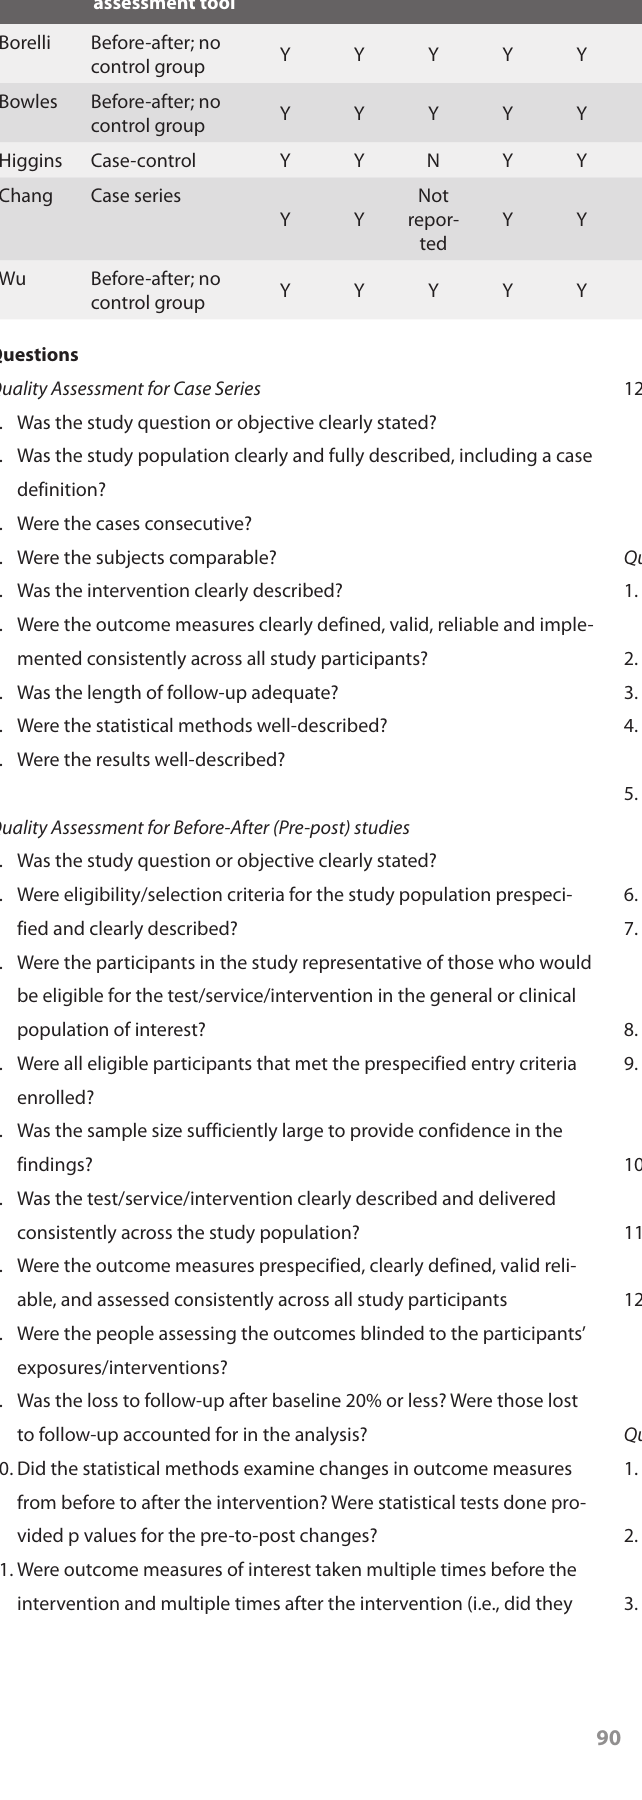
Table 2. National Heart, Lung and Blood Institute Quality assessment tools (NHLBI QA tool). Study Type of study/ assessment tool Borelli Before-after; no control group Bowles Before-after; no control group Higgins